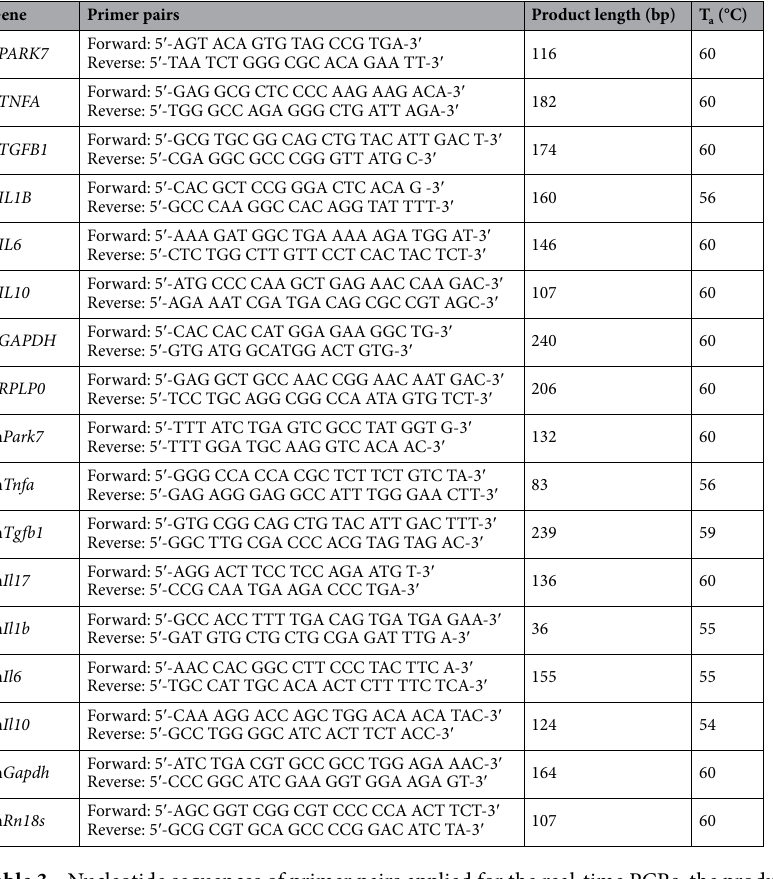
Table 3. Nucleotide sequences of primer pairs applied for the real-time PCRs, the product length and the temperature of anellation. h human, m mouse, bp base pair, Ta annealing